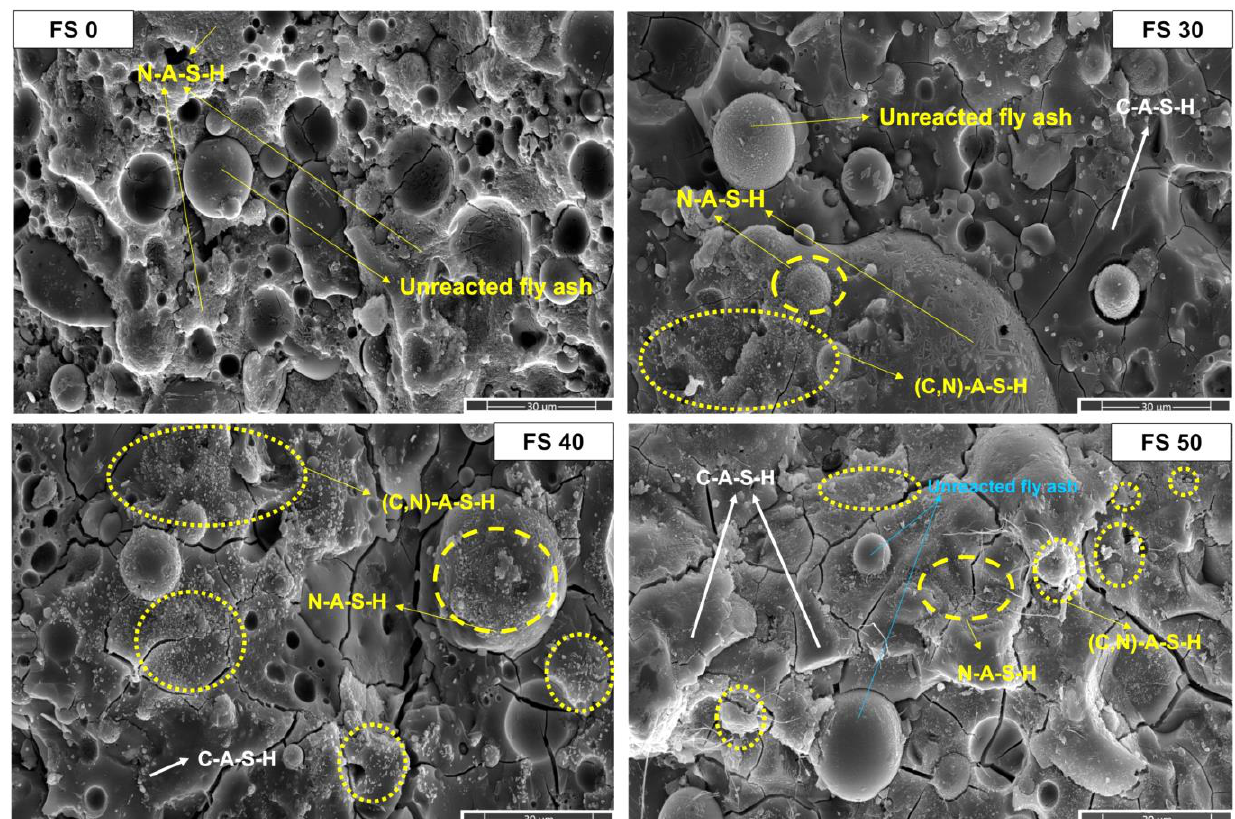
Figure 14. SEM micrographs of AAB with Ms 1.4 exposed to ambient temperature.